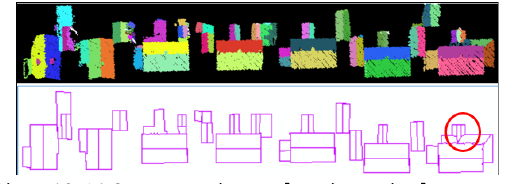
Figure 16. ALS segmentation results using optimal parameters